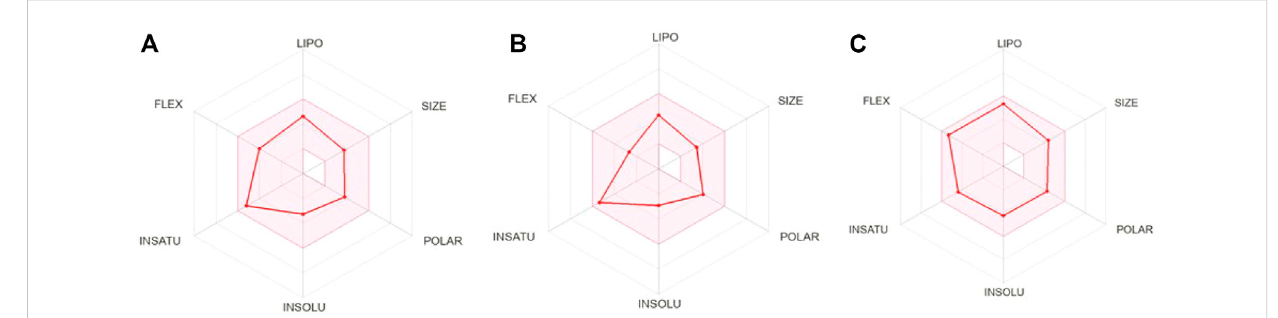
FIGURE 6 Bioavailability radar of (A) 2 ′ - O -ethylmurrangatin ( 1 ), (B) murranganone ( 2 ) and (C) paniculatin ( 3